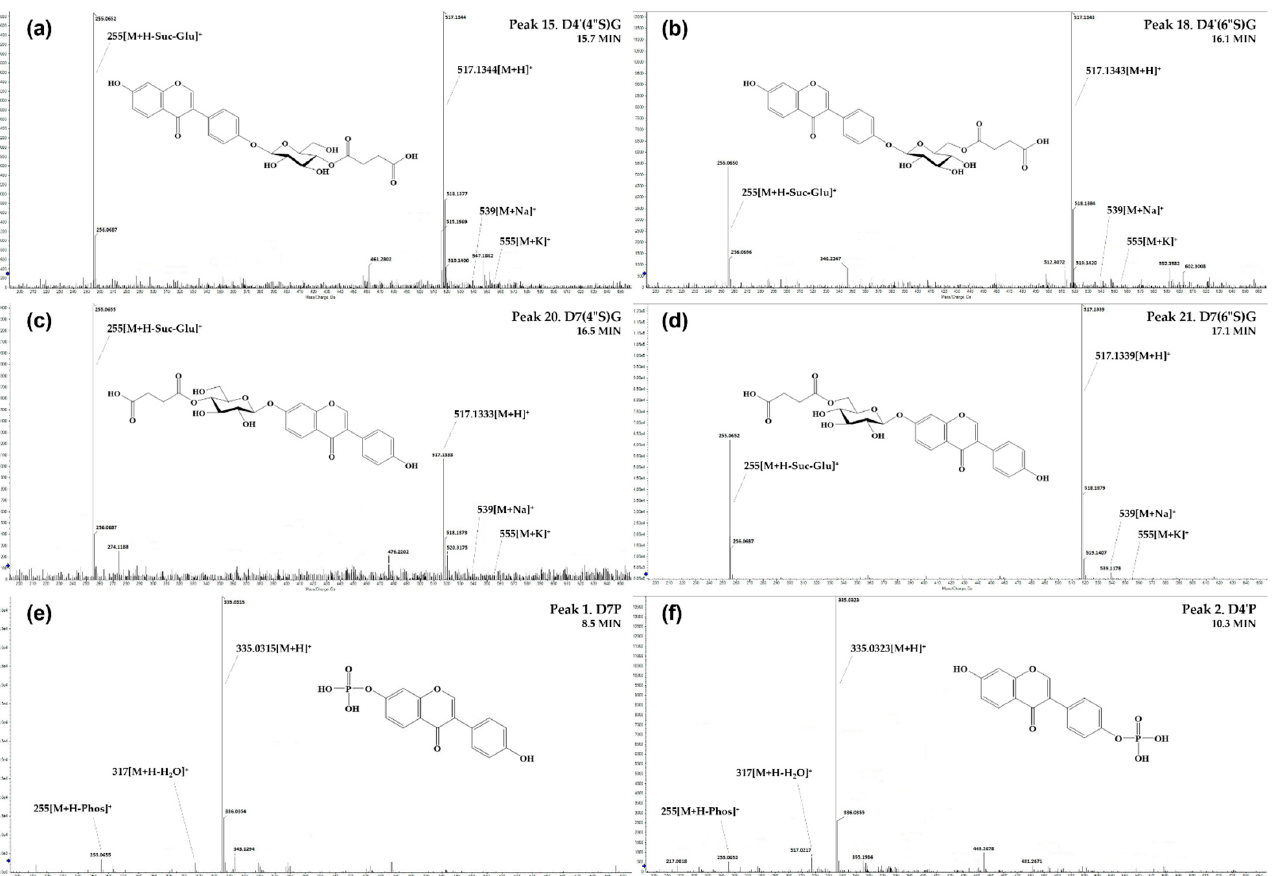
Figure 2. Structures and ESI(+) ‐ QToF/MS characteristics of new succinyl ‐ glucosides ( m / z 517 [M + Figure H] + ) and phosphorylated conjugates ( m / z 335 [M + H] + ) based on daidzein ( m / z 255 [M + H] + ) gener ‐ ated from soybean seeds fermented (after 60 h) with B. subtilis AFY ‐ 2. ( a ) D4 ′ (4 ″ S)G , daidzein 4 ′‐ O ‐ (4 ″‐ O ‐ succinyl)glucoside; ( b ) D4 ′ (6 ″ S)G , daidzein 4 ′‐ O ‐ (6 ″‐ O ‐ succinyl)glucoside; ( c ) D7(4 ″ S)G , dai ‐ dzein 7 ‐ O ‐ (4 ″‐ O ‐ succinyl)glucoside; ( d ) D7(6 ″ S)G , daidzein 7 ‐ O ‐ (6 ″‐ O ‐ succinyl)glucoside; ( e ) D7P , daidzein 7 ‐ O ‐ phosphate; ( f ) D4 ′ P , daidzein 4 ′‐ O ‐ phosphate.